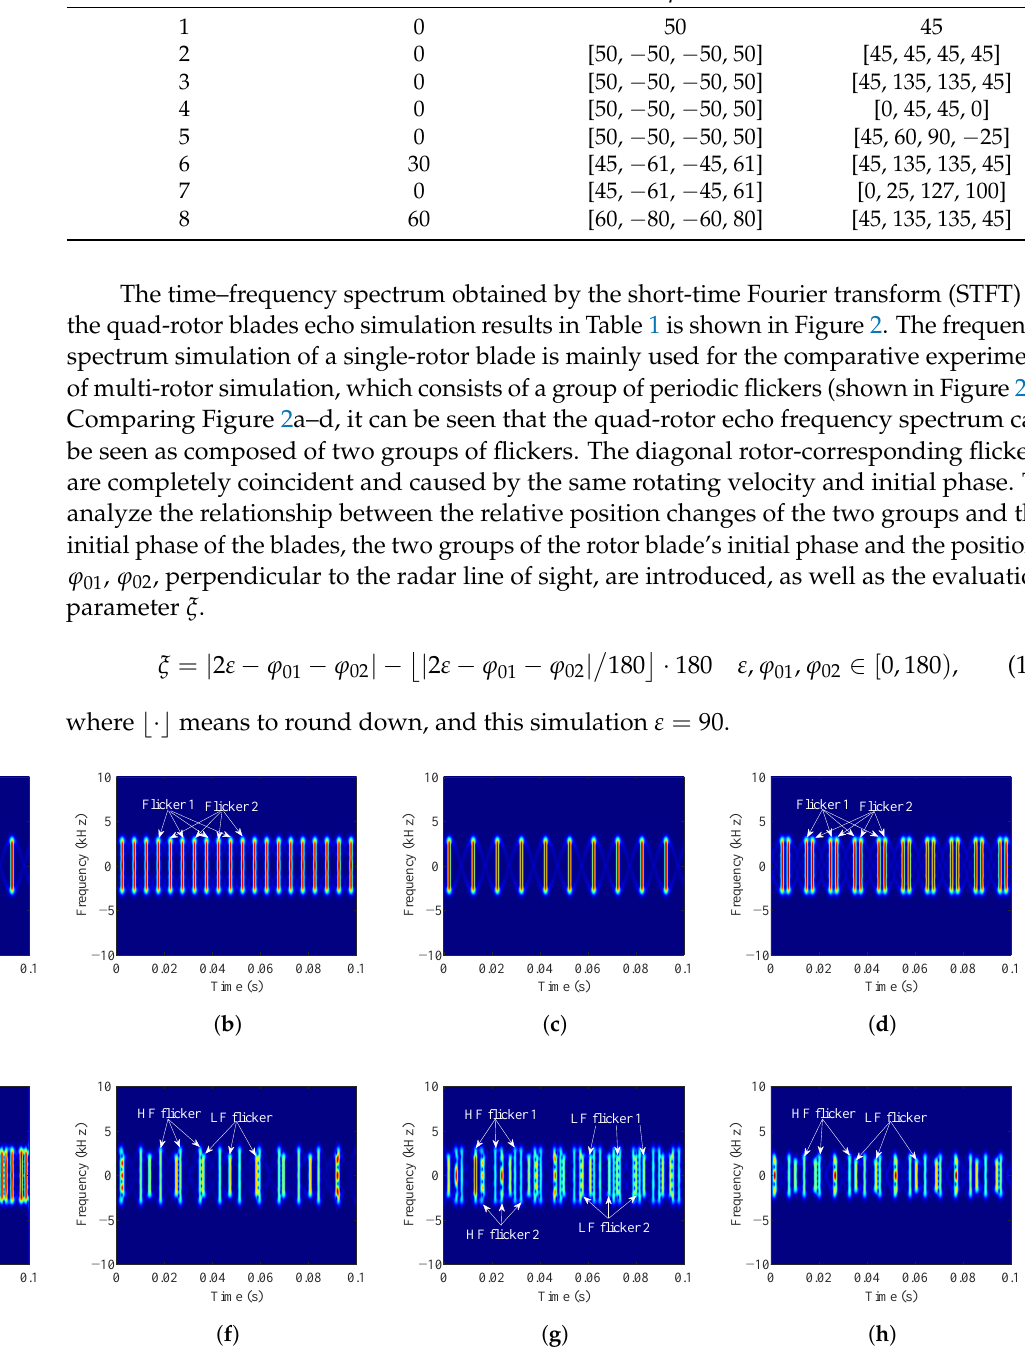
Figure 2. Drone echo time–frequency spectrum in different states. ( a ) Type 1. ( b ) Type 2. ( c ) Type 3. ( d ) Type 4. ( e ) Type 5. ( f ) Type 6. ( g ) Type 7. ( h ) Type 8. When ξ = 0, the two groups of flickers coincide and are consistent with the flicker of a single-rotor. With the increase of ξ , the two groups of flickers will gradually separate. Until the interval between the two groups of flickers reaches the maximum ξ = 90, all flickers are distributed at equal time intervals. The flicker interval is half of the single-rotor flicker interval. When the initial positions of the diagonal rotors are inconsistent, there will